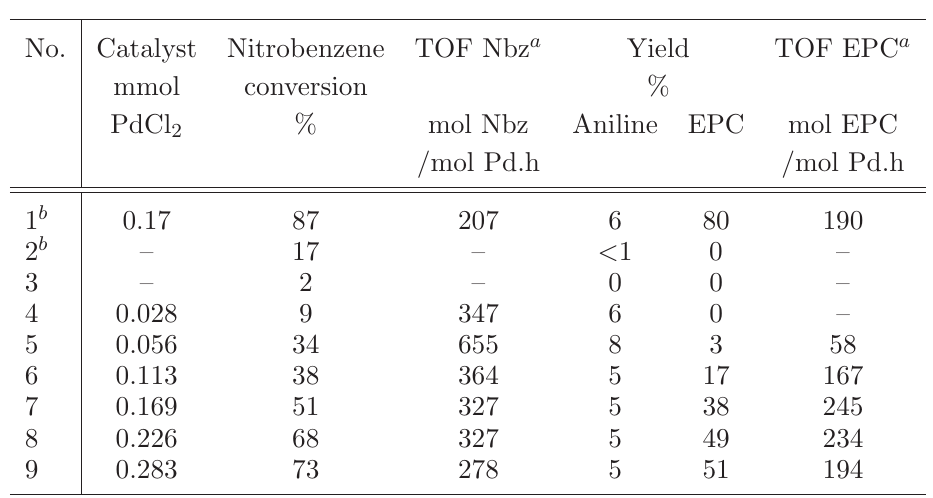
Table 1 The effect of ther amount of PdCl 2 on reductive nitrobenzene carbonylation at a constant Fe/I 2 /Py